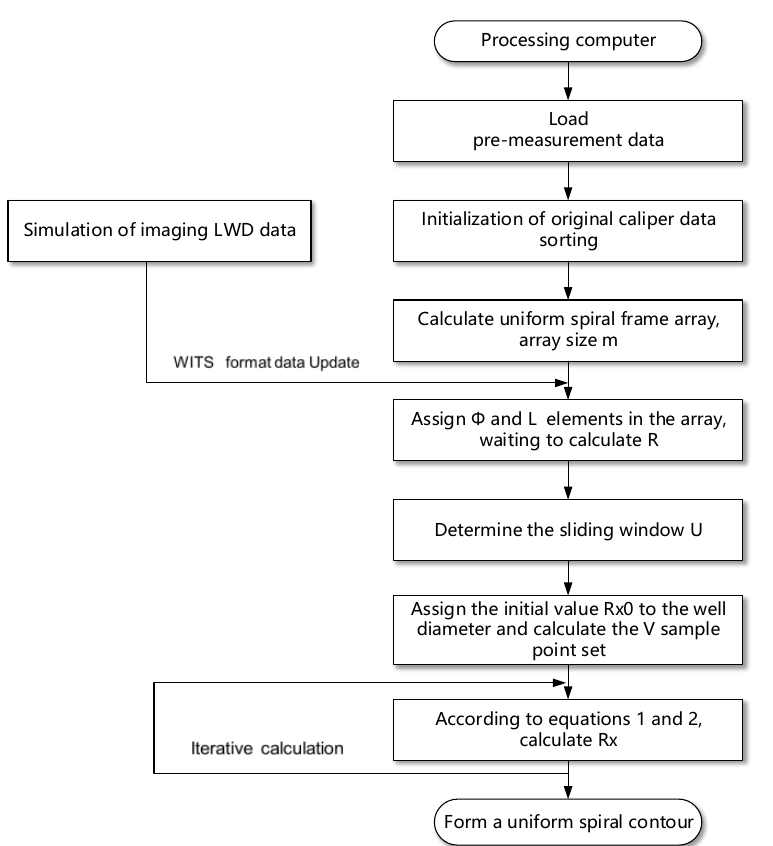
Figure 7. Flow chart for establishing a uniform shaft wall spiral.